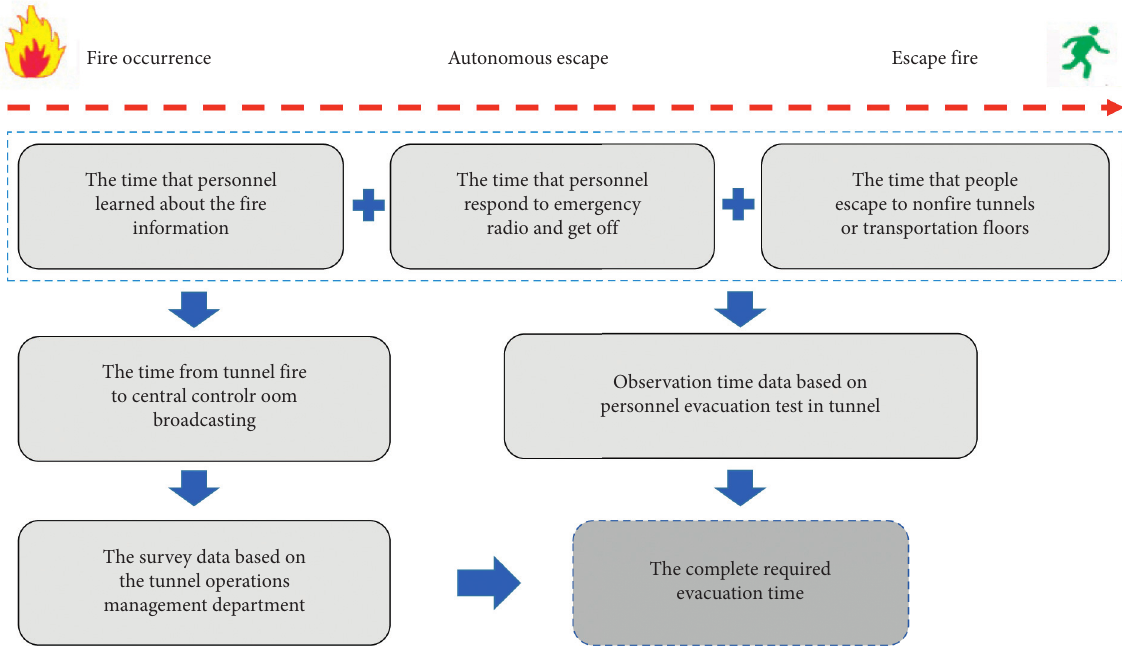
Figure 2: Resolution of personnel evacuation node time.